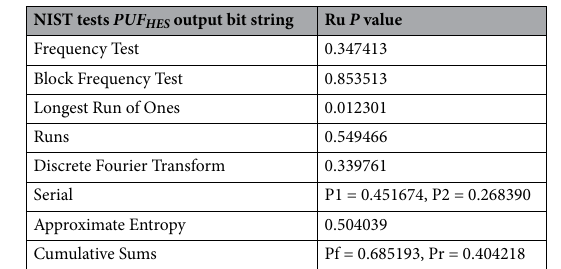
Table 10. NIST 8 tests’ results for PUF HES .